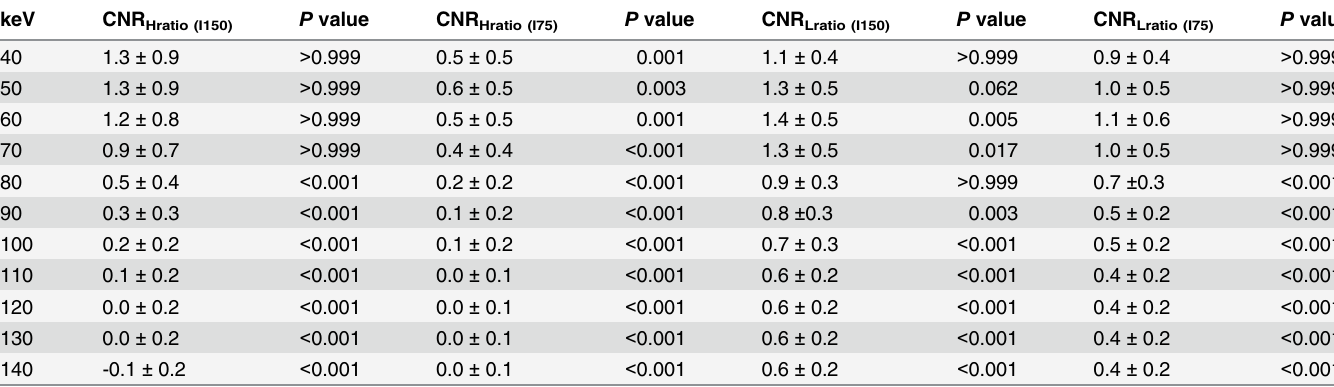
Table 2. CNR ratio in monoenergetic